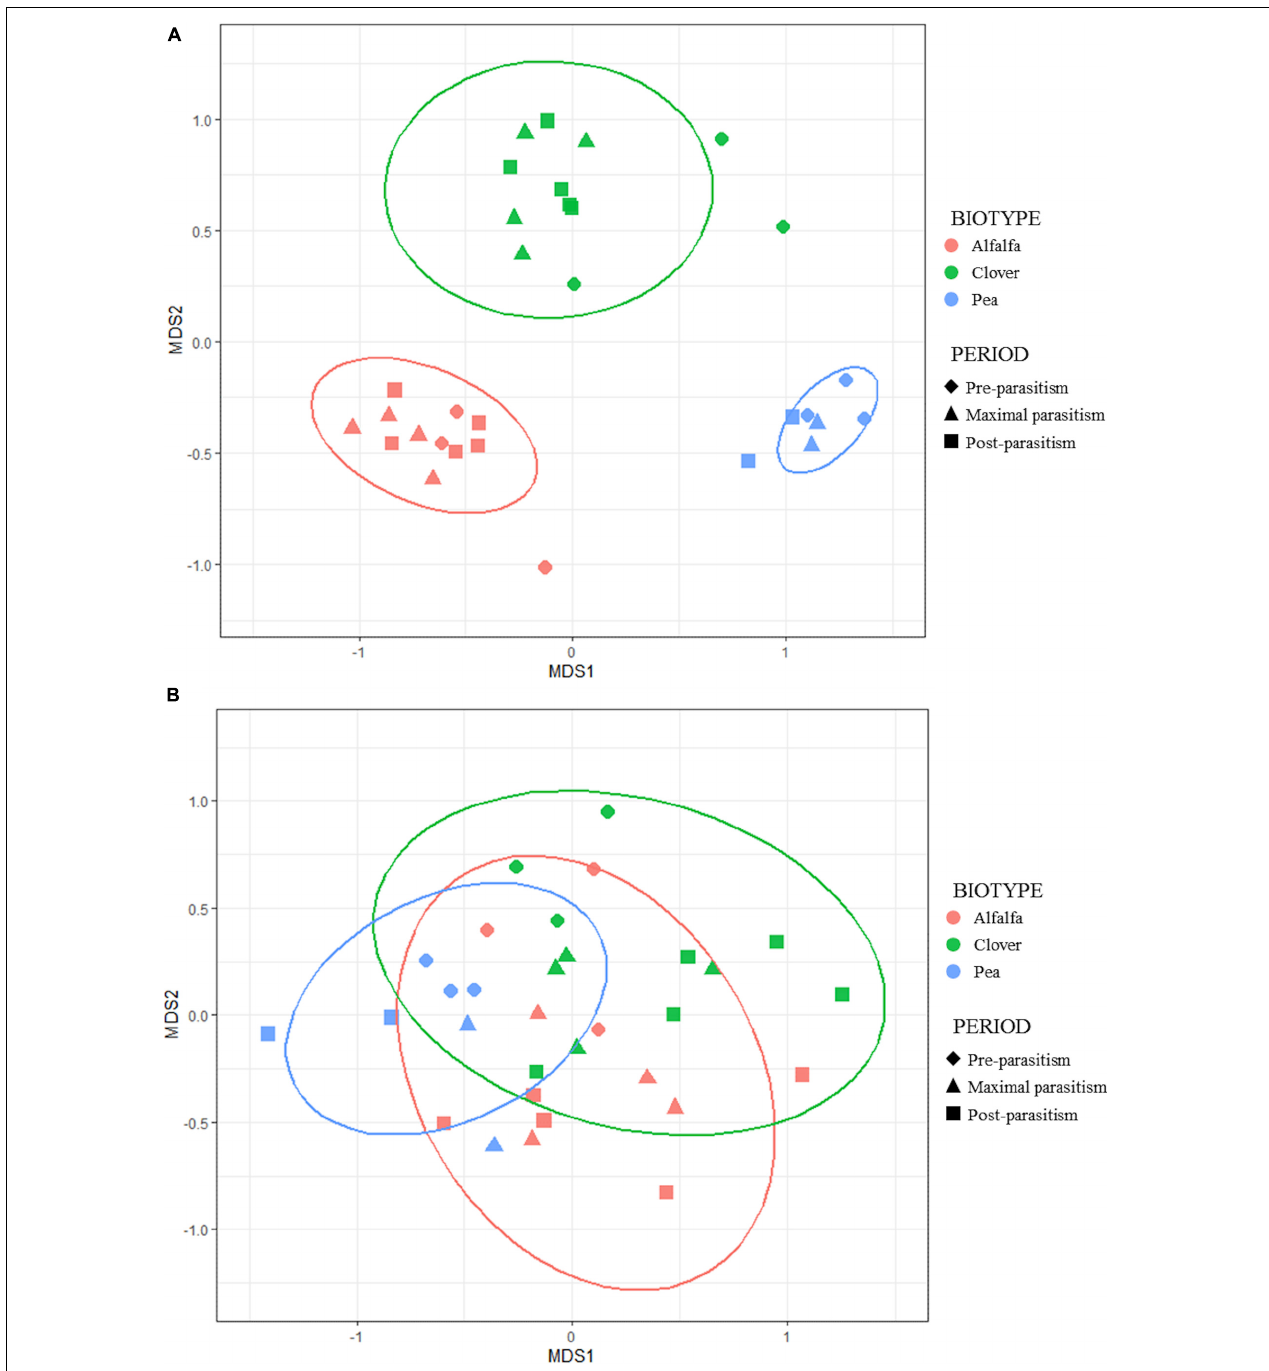
FIGURE 5 | Non-metric MDS ordination plot comparing (A) endosymbiont infection statuses and (B) parasitoid communities from different pea aphid samples. Each data point represents the (A) symbiont/ (B) parasitoid community identified from aphid samples collected at one date for a given biotype. The shape of the dots refers to the parasitism periods. The Bray-Curtis dissimilarity index was used to rank distances calculated using the abundance community data. Stress of the nMDS: (A) symbiont infection status = 0.083; (B) parasitoid community =